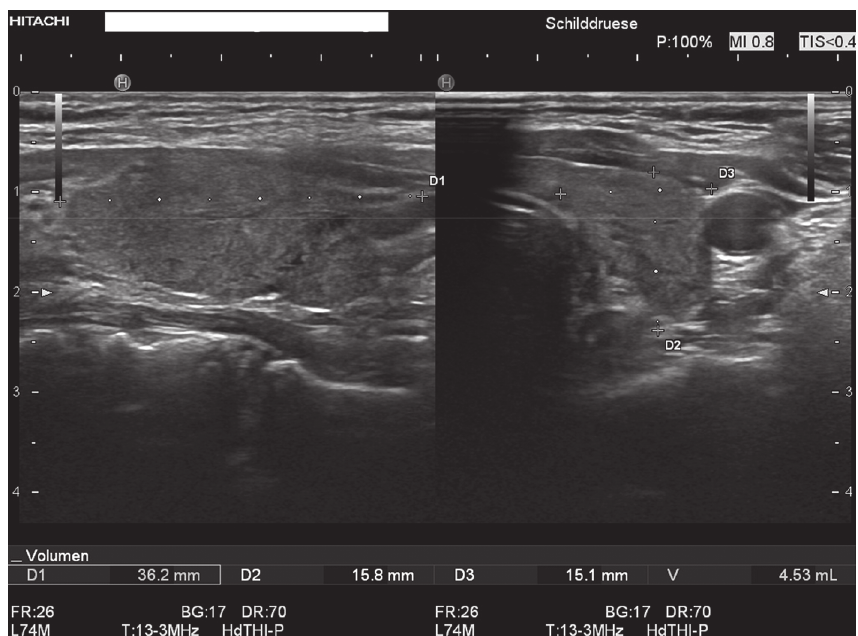
Figure 1: This ultrasound picture shows a hypoechogenic texture with pseudonodular lesions typical for